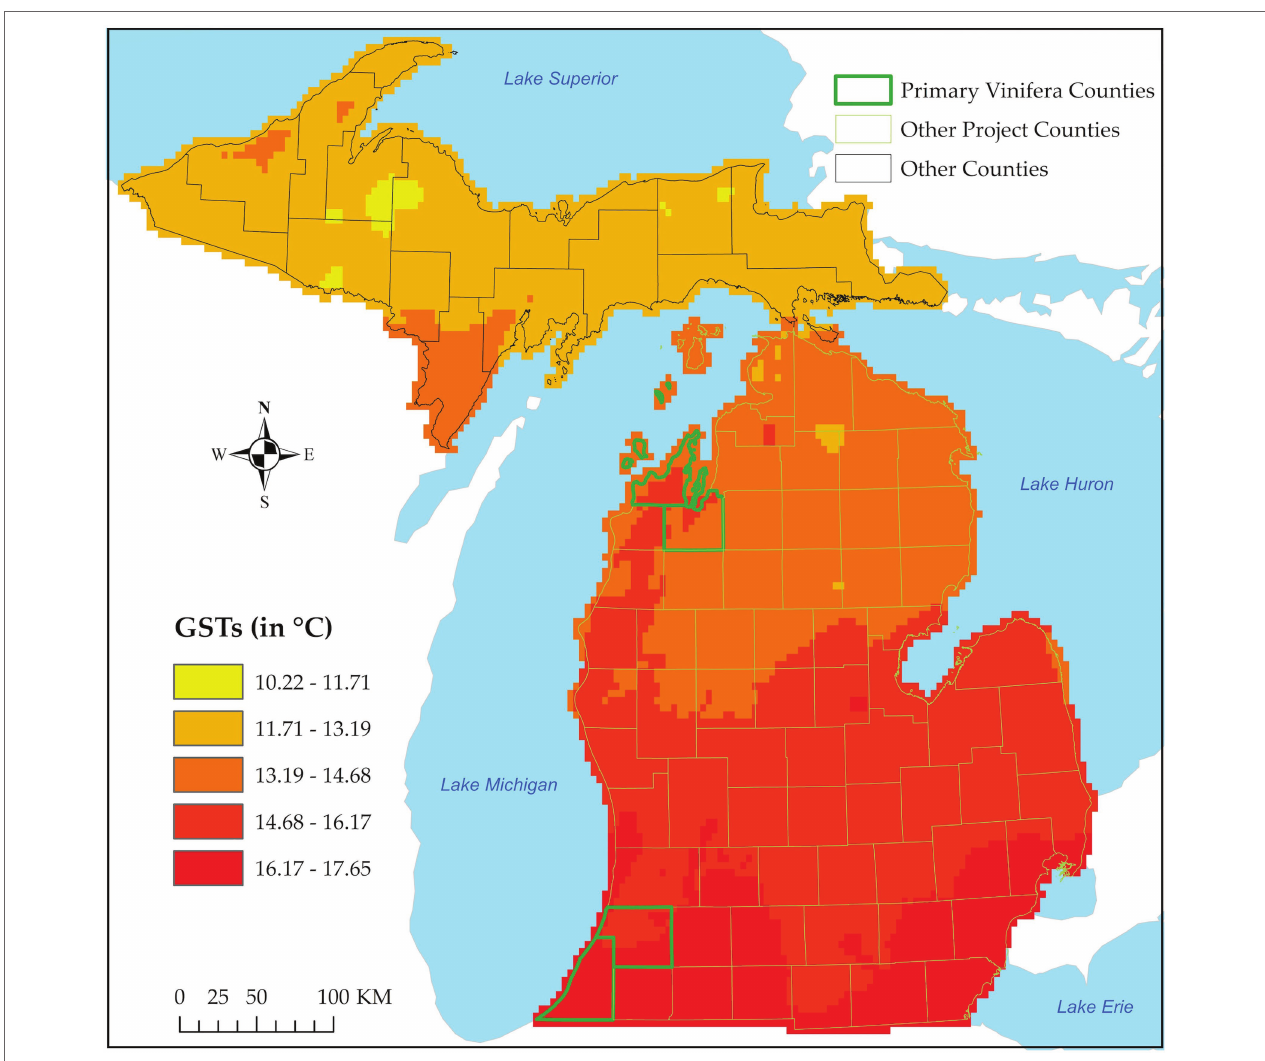
FIGURE 1 | Map of Michigan showing long-term (1983–2019) mean temperatures in the growing season (April–October). Location of the Lower Peninsula counties across the state where trends in climate variables were assessed are outlined in green (traditional counties with vinifera production) and light green (other project counties). Upper Peninsula counties where no trends were assessed are outlined in